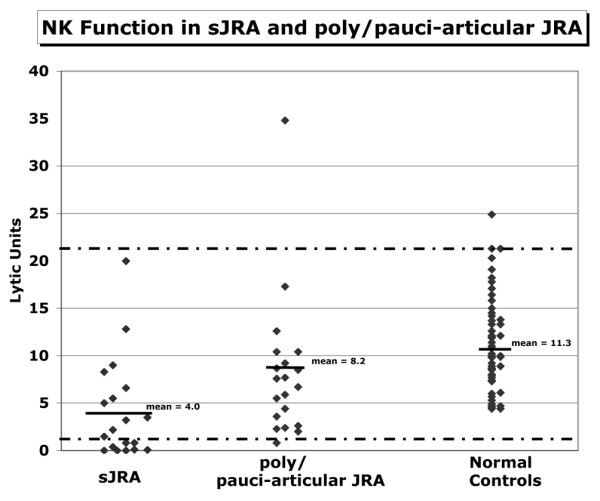
NK cell cytolytic activity in patients with juvenile rheumatoid arthritis (JRA). Activity of NK cells was determined after co-incubation of peripheral blood mononuclear cells with the NK-sensitive K562 cell line and expressed in cytolytic units (LU, y-axis). NK activity values in 20 patients with systemic JRA, 20 patients with other subtypes of JRA and 41 healthy children are shown as dots. The difference between results for patients with systemic JRA and other JRA is statistically significant (Wilcoxon two-sample test, P = 0.0062). For comparison, mean ± 2SD values determined in healthy individuals are shown as horizontal lines.